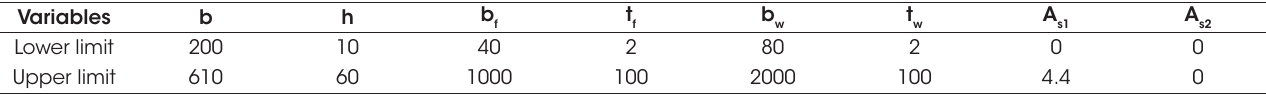
Limit parameter for design variables (dimensions in mm and area in cm 2 )